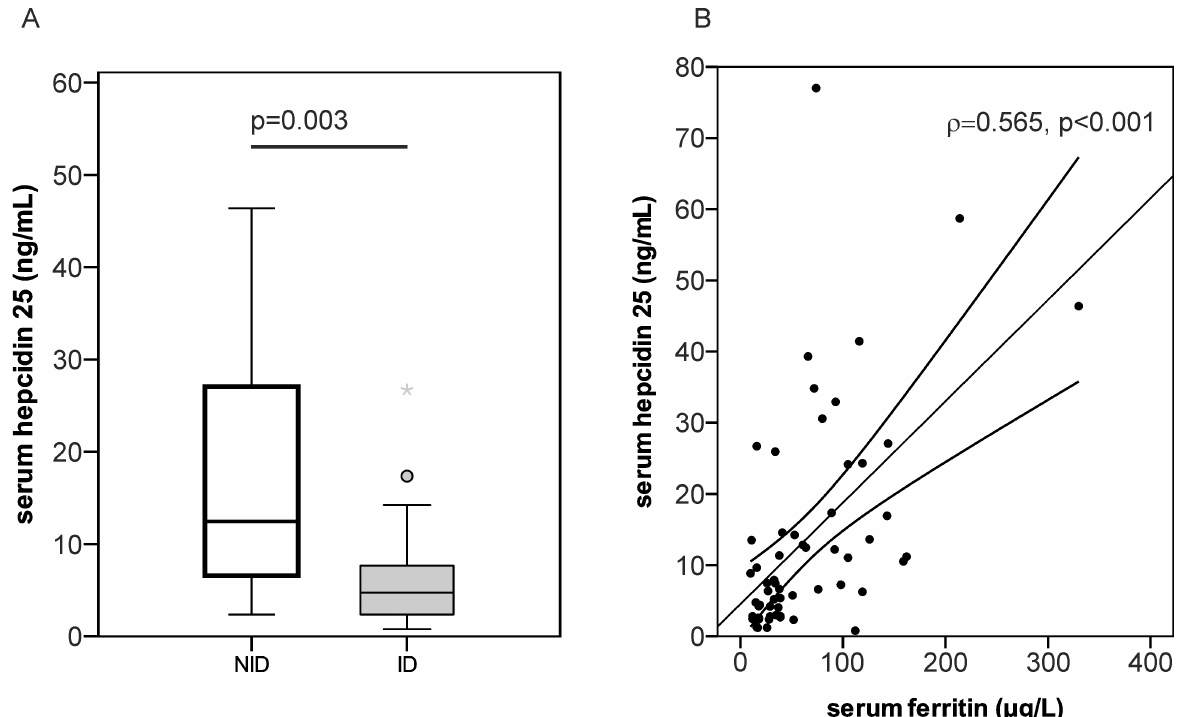
Fig 5. Serum hepcidin in iron deficient (ID) and non-iron deficient (NID) precapillary pulmonary hypertension patients. (A) Serum hepcidin 25 expression in iron deficient (ID) and non-iron deficient (NID) patients. (B) Correlation of serum hepcidin 25 with serum ferritin. ID was defined according to the soluble transferrin receptor/logferritin index (sTFRF index, ID5: sTFRF index > 3.2 if CRP < 0.5mg/dL or sTFRF index > 2 if CRP > 0.5mg/dL); N = 45; ρ , Spearman rho correlation coefficient; p, p-value as reported by Spearman rho test.